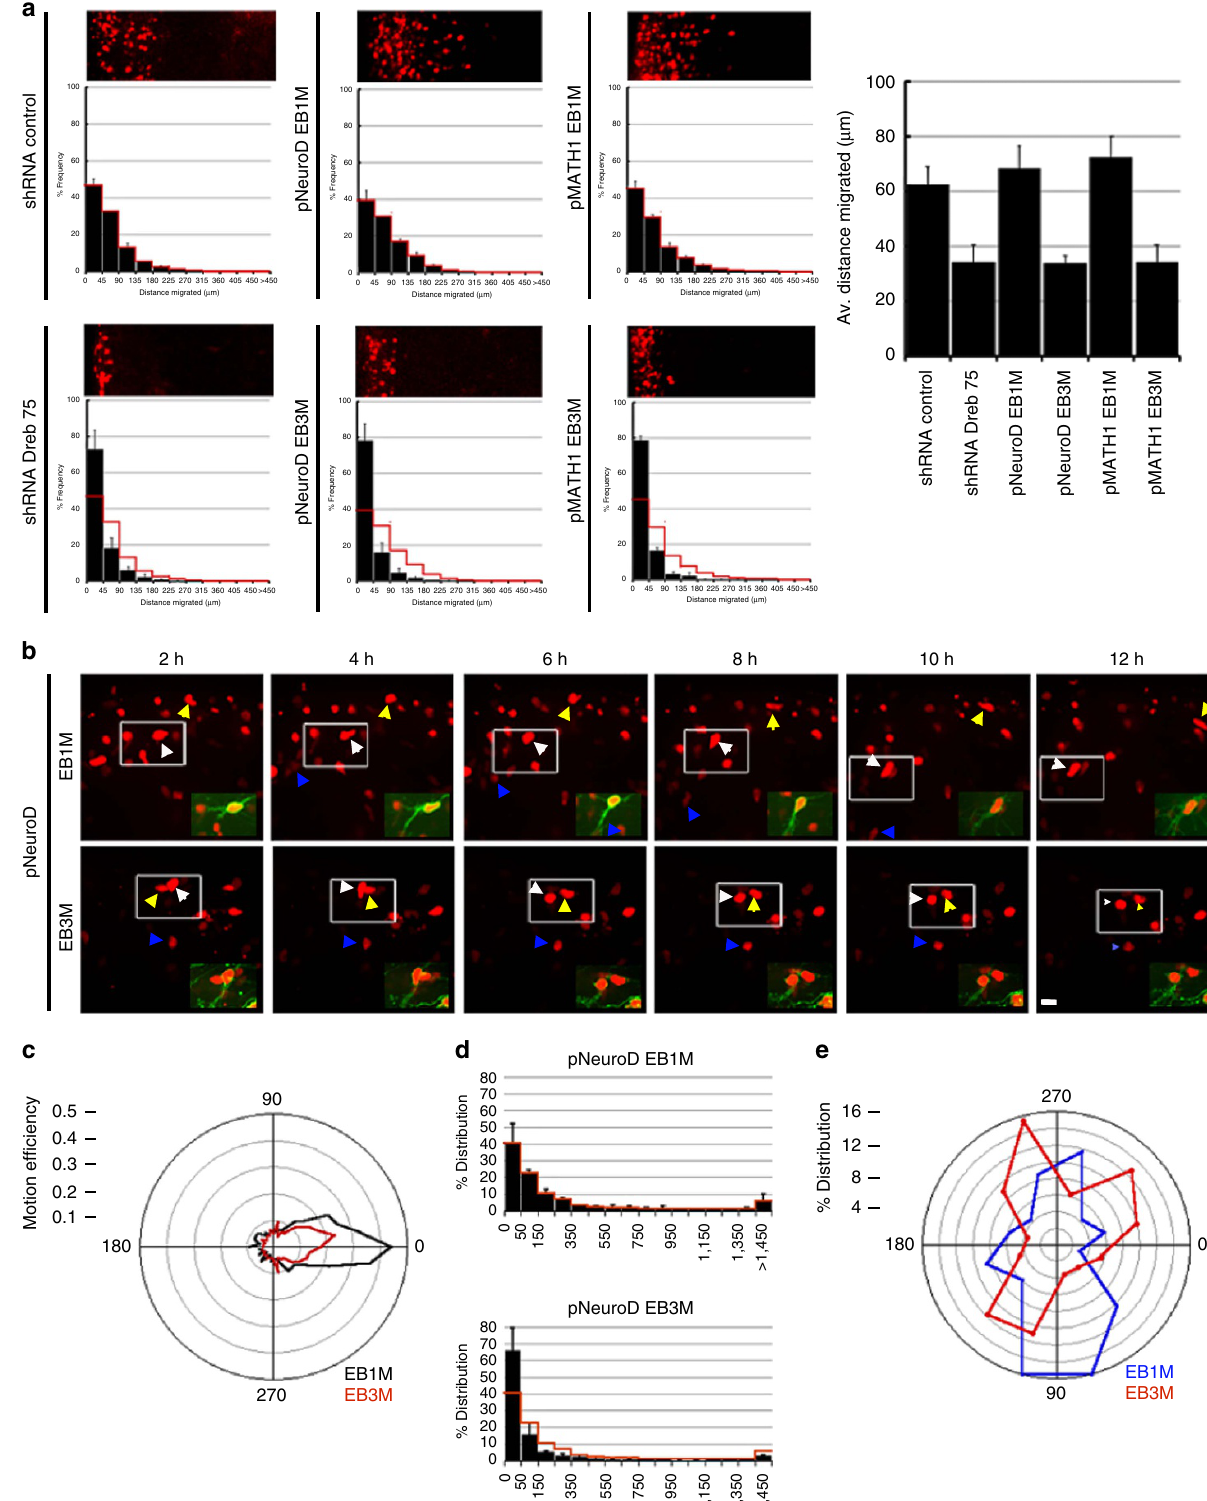
NATURE COMMUNICATIONS|8:14484|DOI: